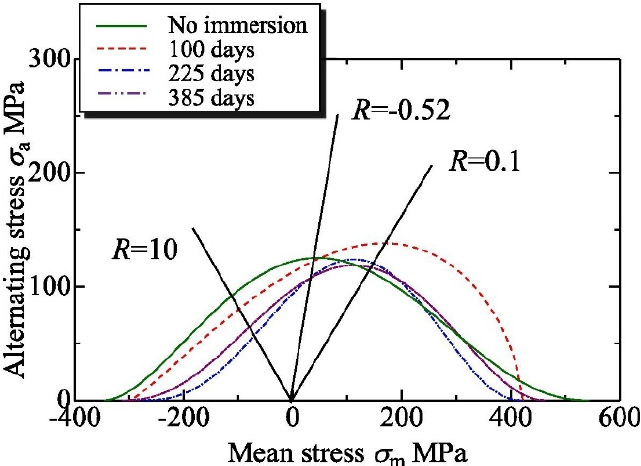
Figure 17. Constant life diagrams for plain-woven CFRP aged in seawater for different times. Adapted with permission from Ref. [167]. Copyright 2019 Elsevier.